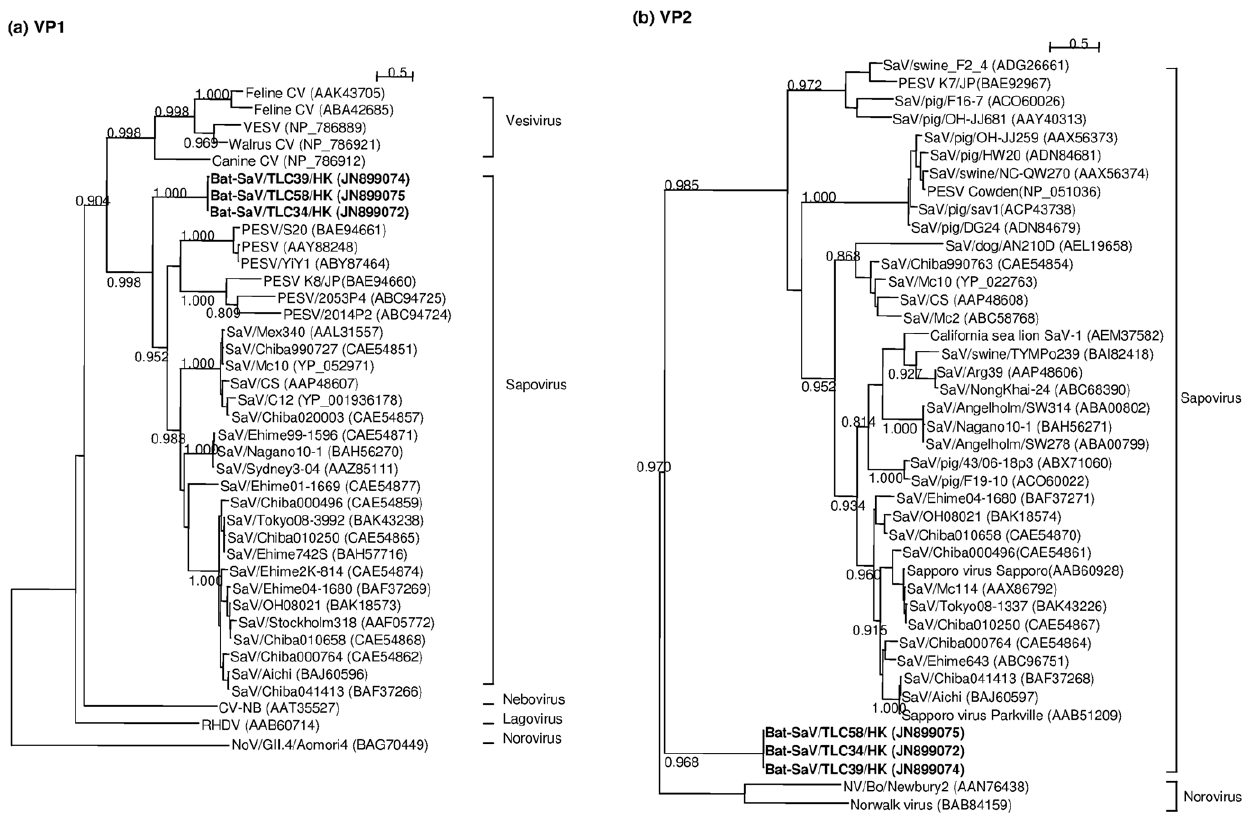
Figure 3. Unrooted maximum-likelihood trees of VP1 and VP2. The trees were constructed based on the full-length amino acid sequences of (a) VP1 major capsid protein, and (b) VP2 minor structural protein. SH-like aLRT branch support values of greater than 0.70 are shown besides major branches. Scale bar indicates the number of inferred substitutions per site.